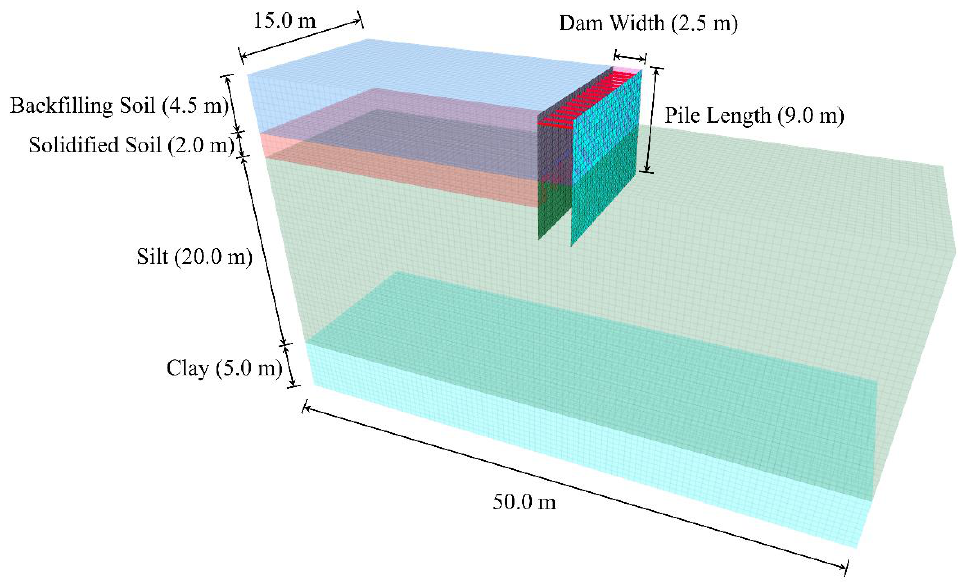
Figure 8. Mesh of the numerical model. Table 2. Stages of construction in finite difference analysis. Stage